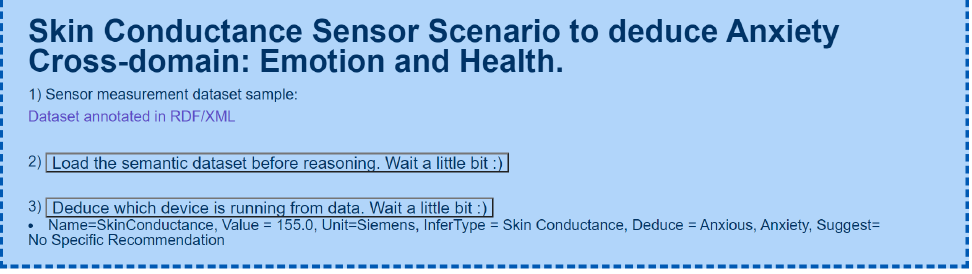
Figure A13. Deducing anxiety from skin conductance.